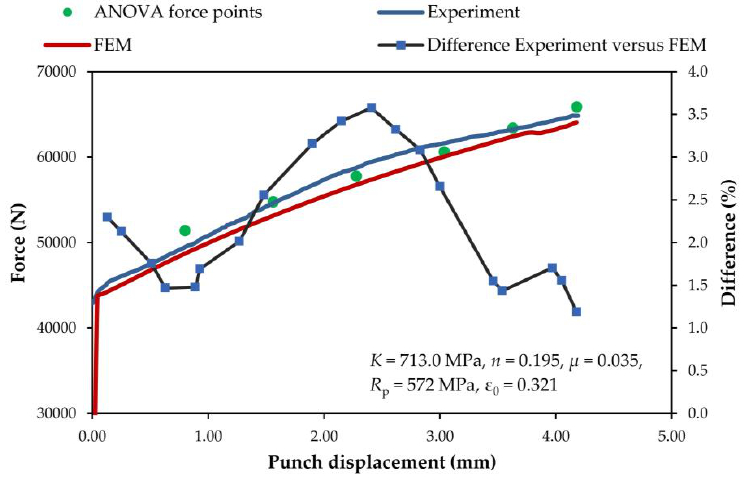
Figure 4. Comparison of force course for selected material parameters from Table